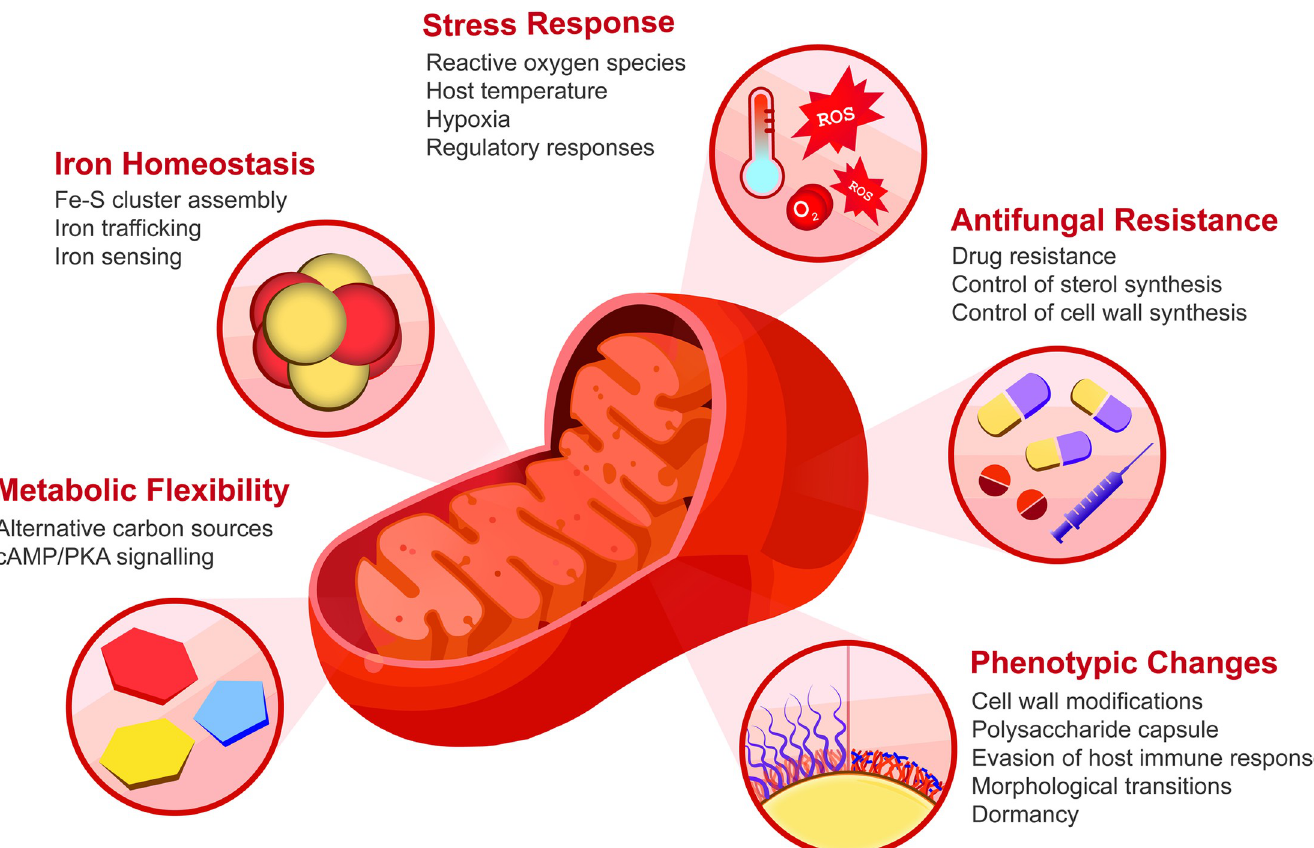
Fig 1. Mitochondrial-associated activities that impact fungal pathogenesis. Mitochondria play key roles in stress responses and metabolic activities (e.g., iron homeostasis and use of carbon sources) relevant to fungal proliferation in mammalian hosts. Recent studies emphasize the prominent participation of the ETC in virulence, and the targets of inhibitors of specific complexes are shown in Fig 2. The phenotypic outcomes of perturbed mitochondrial function include cell surface changes that directly influence evasion of the host immune response. Critically important activities related to drug susceptibility and resistance are the subject of